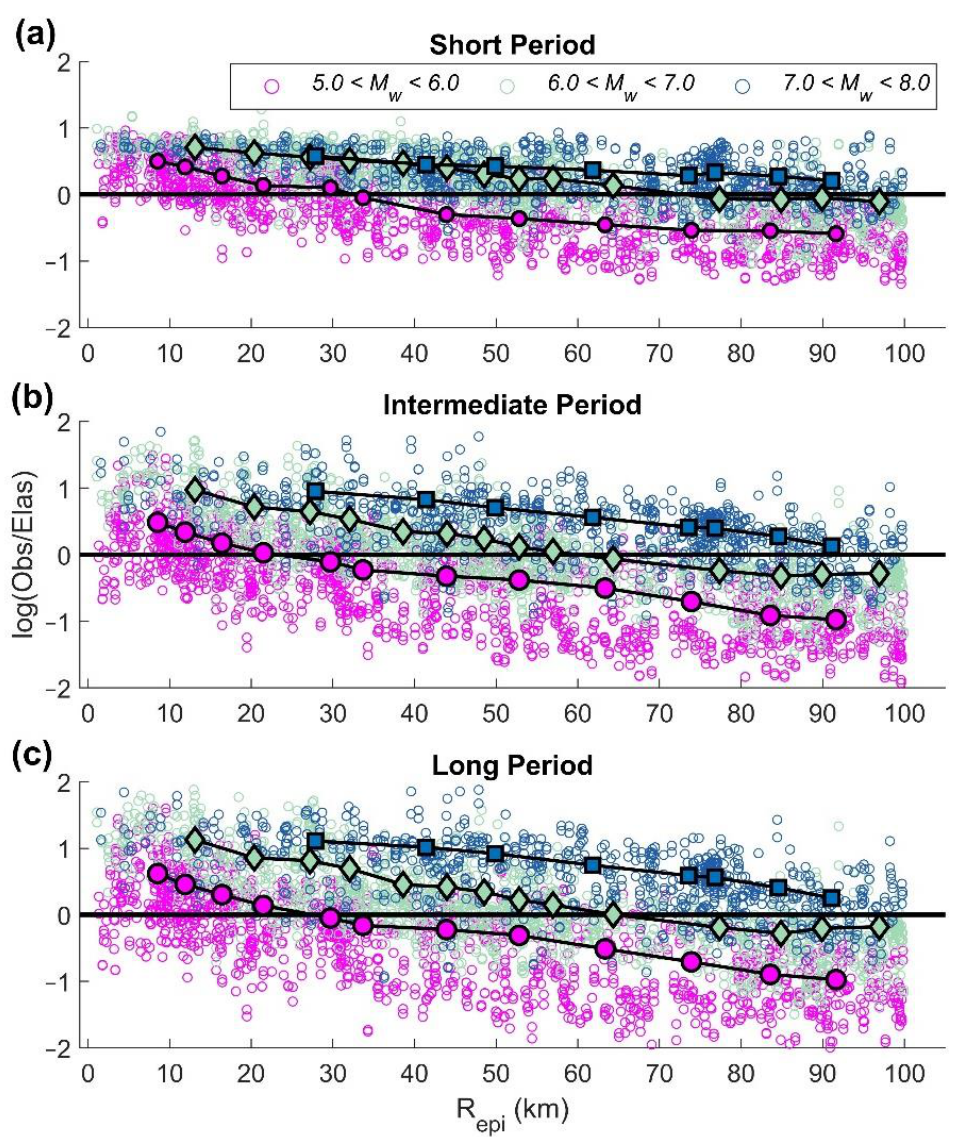
Figure 10. Logarithmic ratio of observed EDP and elastic limit for SP, IP and LP structures ( a – c ). The black solid line is the elastic limit for SP, IP and LP structures respectively. The colors show ground motion grouped into different magnitude bins. The solid lines are the moving averages of logarithmic ratio of observed EDP and elastic limit. As epicentral distance increases, the records rather produce elastic responses and hence show larger